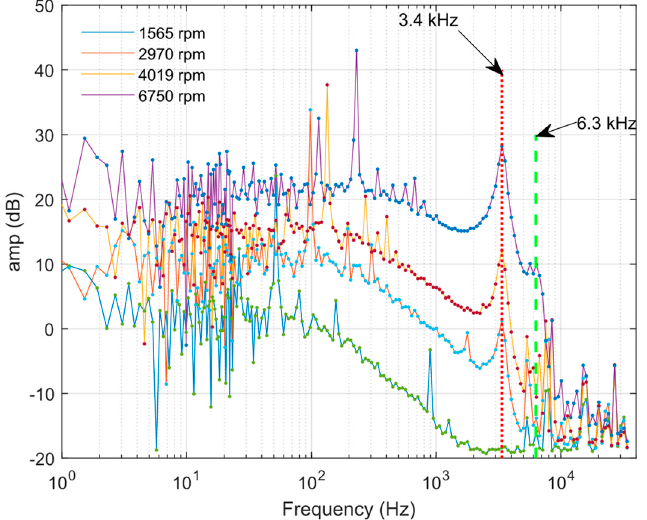
Figure 13. Frequency analysis results for selected RPM values, with marked frequencies.